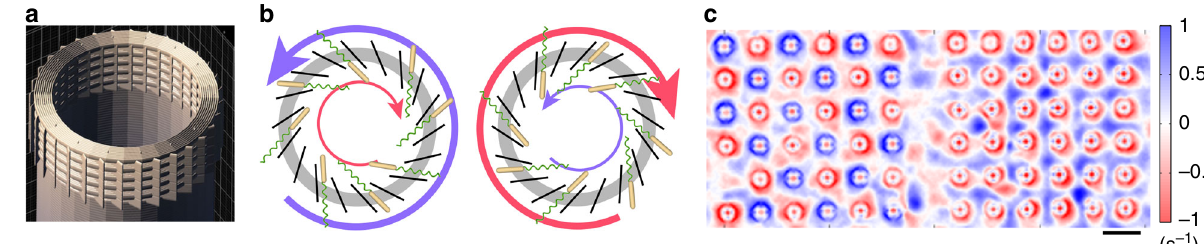
Fig. 5 Bacterial vortex lattices in the presence of chiral towers. a 3D model of chiral tower. The top part consists of fi ve 3- μ m thick hollow disks spaced at 3- μ m vertical distance from each other. These disks are supported by 1- μ m thin vertical walls oriented at 45° relative to the radius. b Chiral towers create internal and external hydrodynamical bacterial vortices due to specially oriented holes in their tips. c Vorticity map of bacterial fl ow between antiferromagnetic (left) and ferromagnetic (right) chiral tower arrays. Scale bar: 100 μ